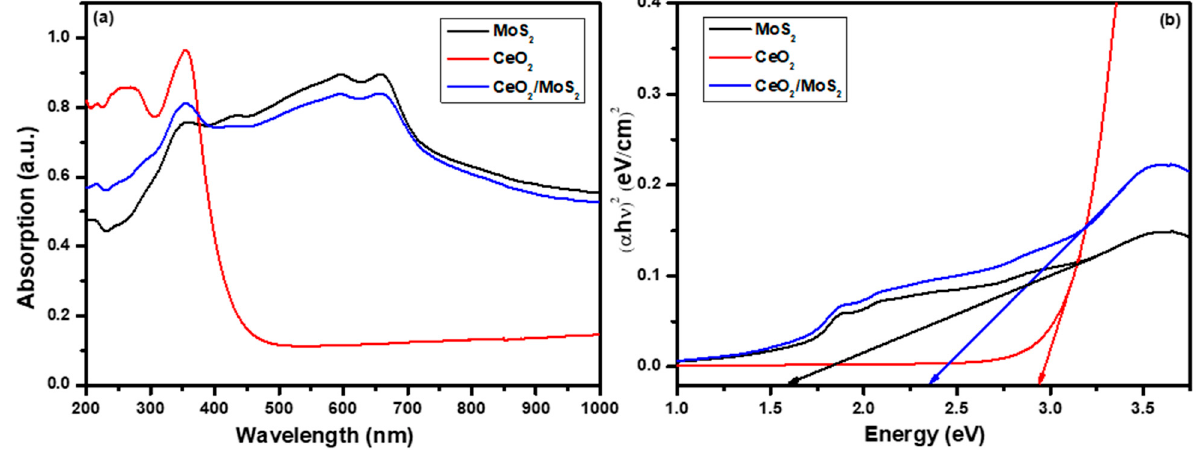
Figure 5. ( a ) Absorption spectra and ( b ) bandgap plots of MoS 2 and CeO 2 /MoS 2 composite. Using the absorption data, the bandgap values were estimated. Figure 5b shows the plot of ( α h ν ) 2 vs. h ν for MoS 2 , CeO 2 , and the CeO 2 /MoS 2 composite. Using the following equation, bandgap energy, i.e., the energy difference between the conduction and valence bands, was calculated [31]: